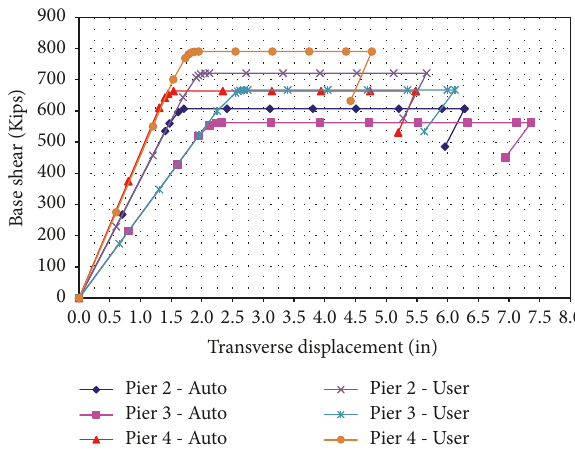
Figure 4: Transverse pushover capacity curve of Bridge